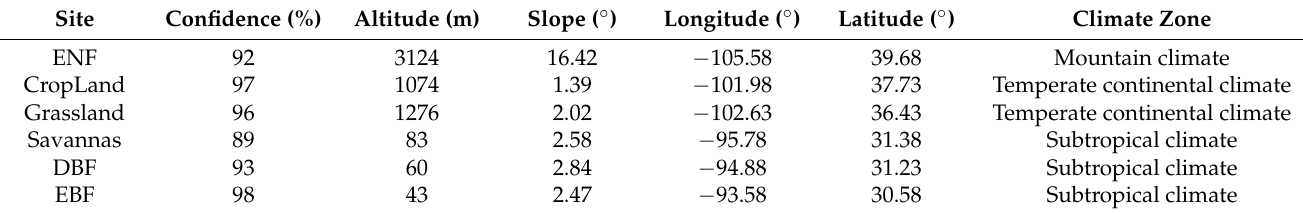
Table 1. Statistics of Study